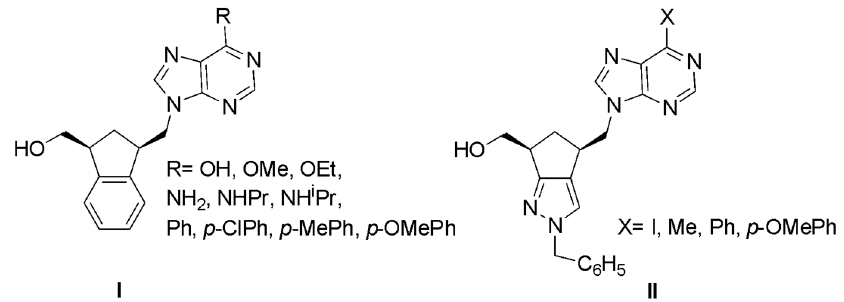
Figure 1. Carbanucleosides with an aromatic or heteroaromatic cycle in their structure.